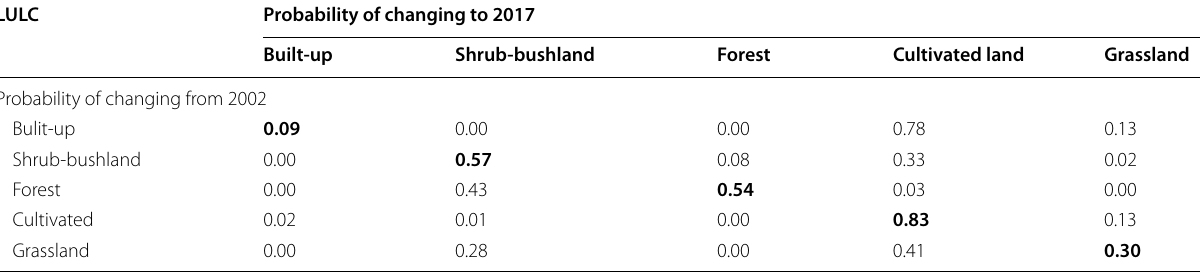
The bold number indicates the total area of each LULC class that remained